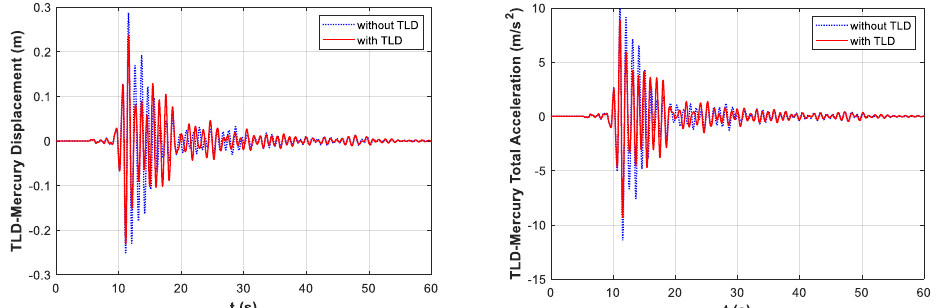
Figure 4. AHS optimization of the single-story structure displacement – time and total acceleration – time graphs in the DUZCE/BOL090 earthquake record for TLD – acetone.